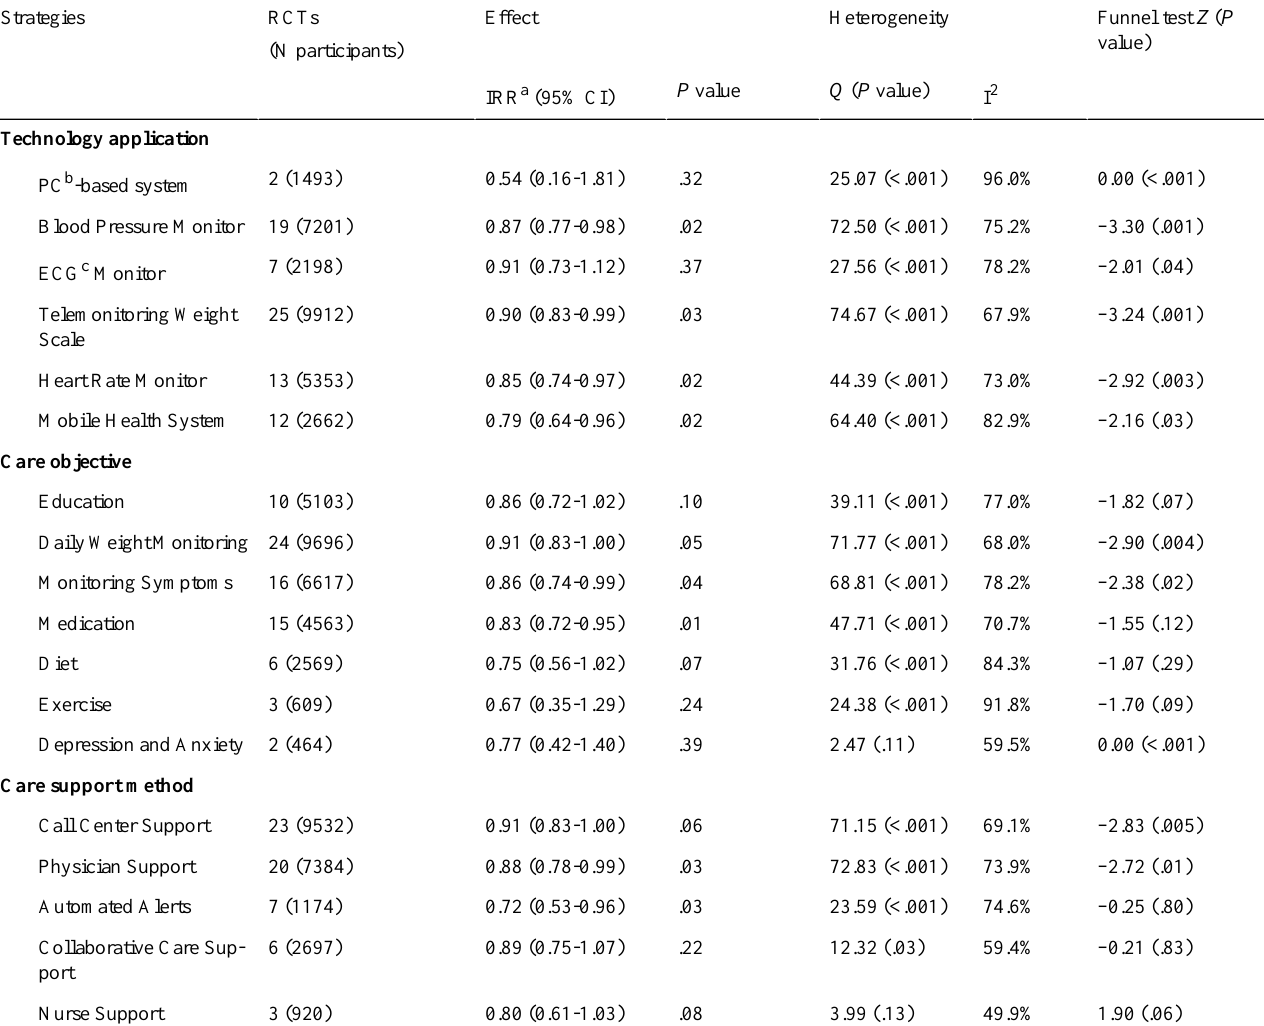
Table 4. Subgroup meta-analysis to examine the effect of telemonitoring strategies on all-cause hospitalization for randomized controlled trials (RCTs) that applied the strategy in the telemonitoring intervention (subgroup